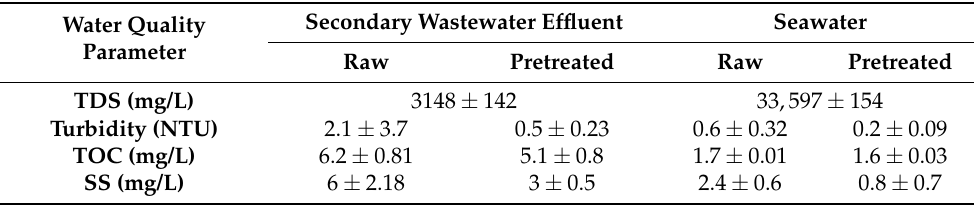
Table 1. Characteristics of seawater and secondary wastewater